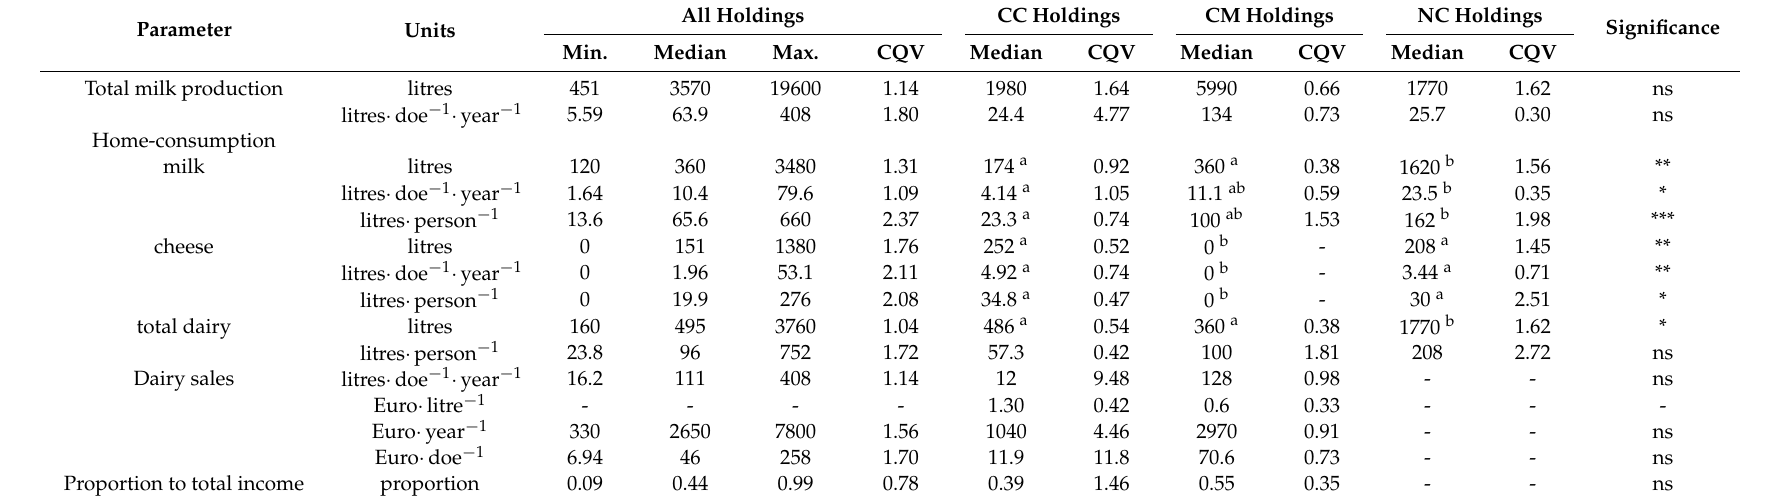
Table 5. Descriptive statistics for parameters relating to the dairy production on ten goat holdings in the northern region of Morocco based on monthly data collections between September 2009 and August 2012. Holdings are classified by their dairy production status: commercial cheese (CC, n = 3), commercial milk (CM, n = 4) and non-commercial dairy (NC, n =